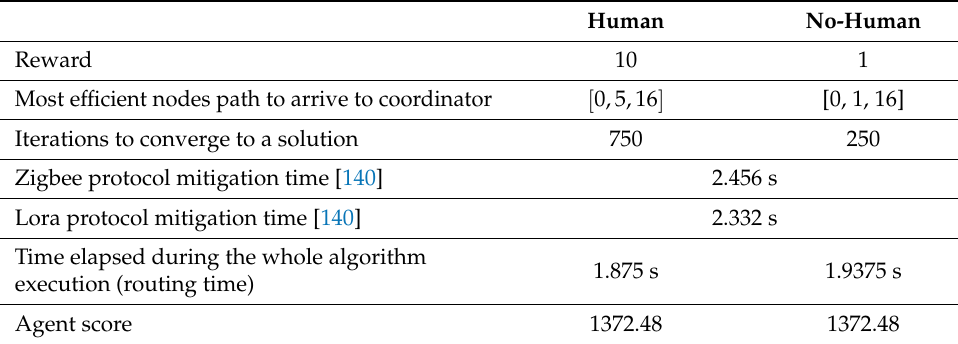
Table 10. Jamming routing simulation for mitigation results.